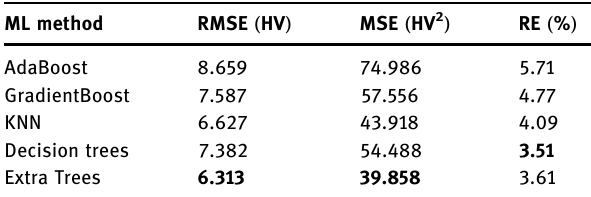
Table 5: Surface hardness prediction performance using di ff erent ML methods with PCA decomposition